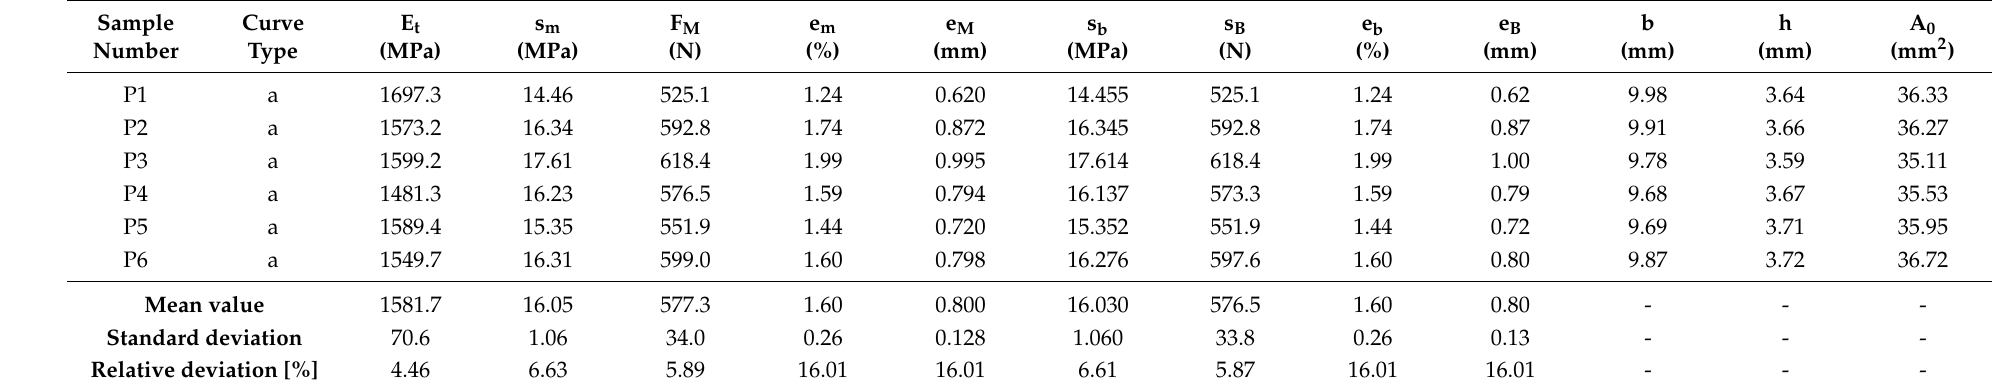
Table A32. Results of the tensile tests of P_C,PP.